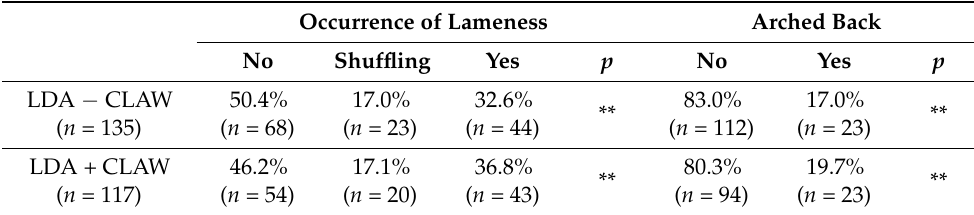
Table 5. Distribution of occurrence of lameness and an arched back in cattle diagnosed with left displacement of the abomasum and no claw lesion (LDA − CLAW) or at least one claw le- sion (LDA + CLAW). ‘Shuffling’ was defined as shuffling with both hind limbs. Results with a p -value < 0.05 were considered statistically significant. Significant differences < 0.01 are indicated as **. Occurrence of Lameness Arched Back